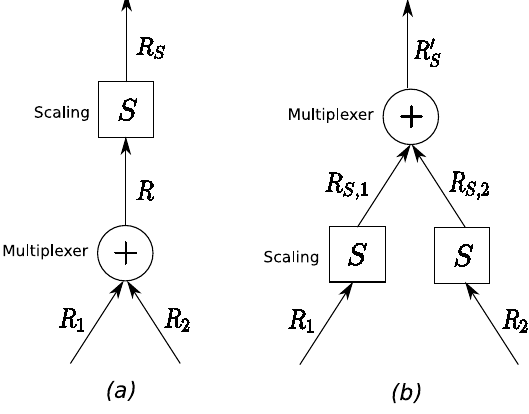
Figure 6. Scaling element with